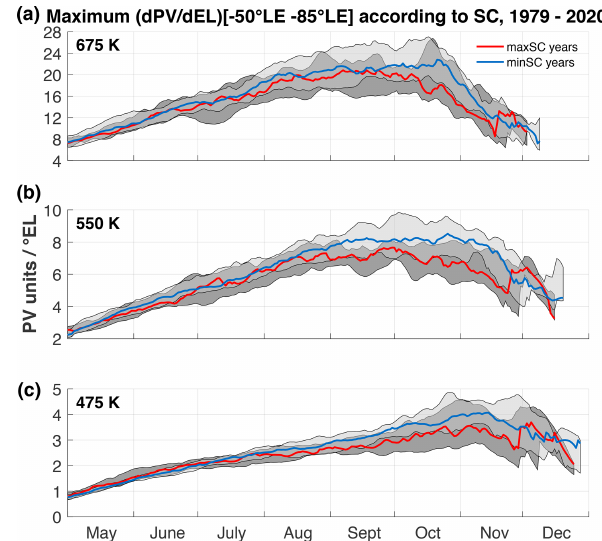
Figure 2. Evolution of daily position of the vortex edge in equiva- lent latitude as a function of time over the period 1979–2020, from (a) to (c) : 675, 550, and 475K. Median values are represented by the bold black curves. Blue areas show values between the 20th and 80th percentiles, while thin black curves represent the maximum and minimum values during the period.